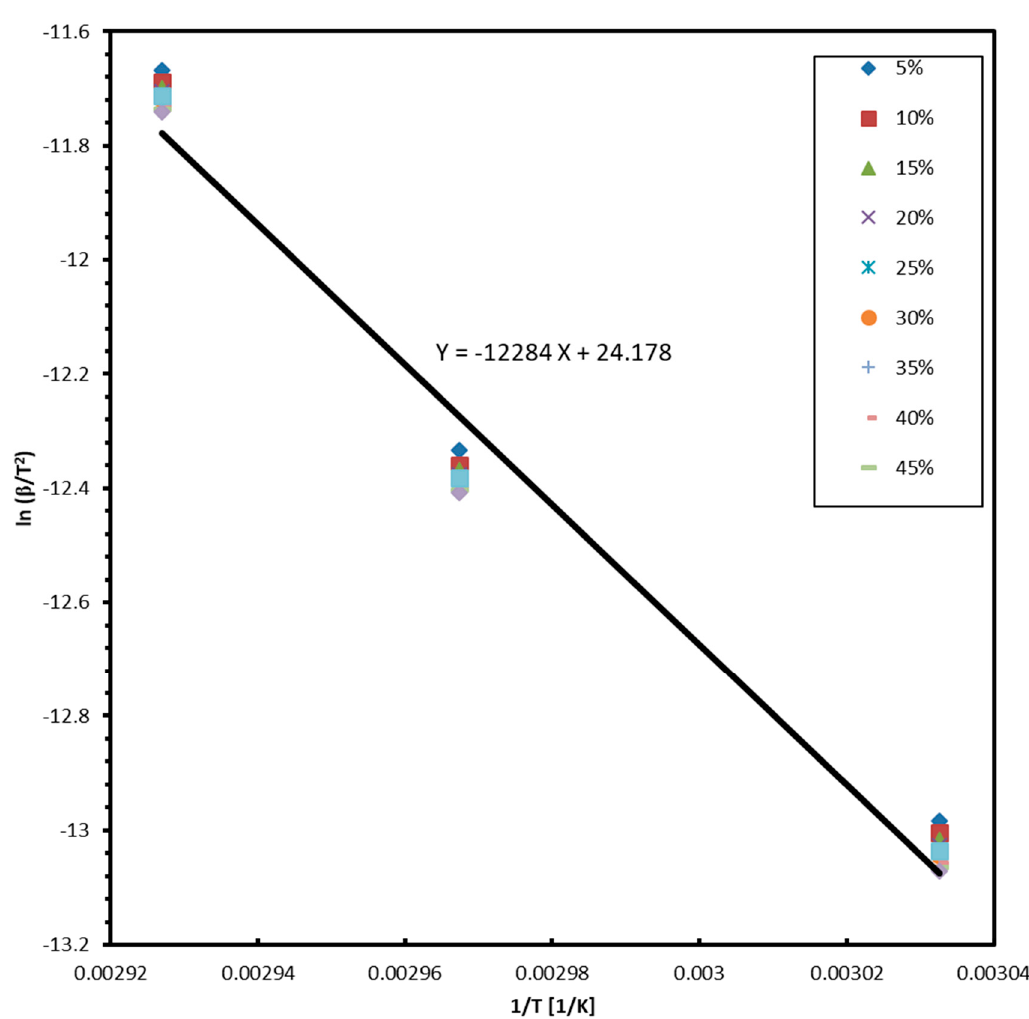
(cid:0) (cid:1) Figure 4. Plot of (cid:1864)(cid:1866)((cid:2010)/(cid:1846) (cid:2870) ) versus the inverse of the absolute temperature with weight loss from 0.05 Figure 4. Plot of ln β / T 2 versus the inverse of the absolute temperature with weight loss from 0.05 to 0.5 in steps of 0.05 according to Flynn–Wall method ( β = 0.25, 0.5, 1.0 to 0.5 in steps of 0.05 according to Flynn–Wall method ( β = 0.25, 0.5, 1.0 K/min).